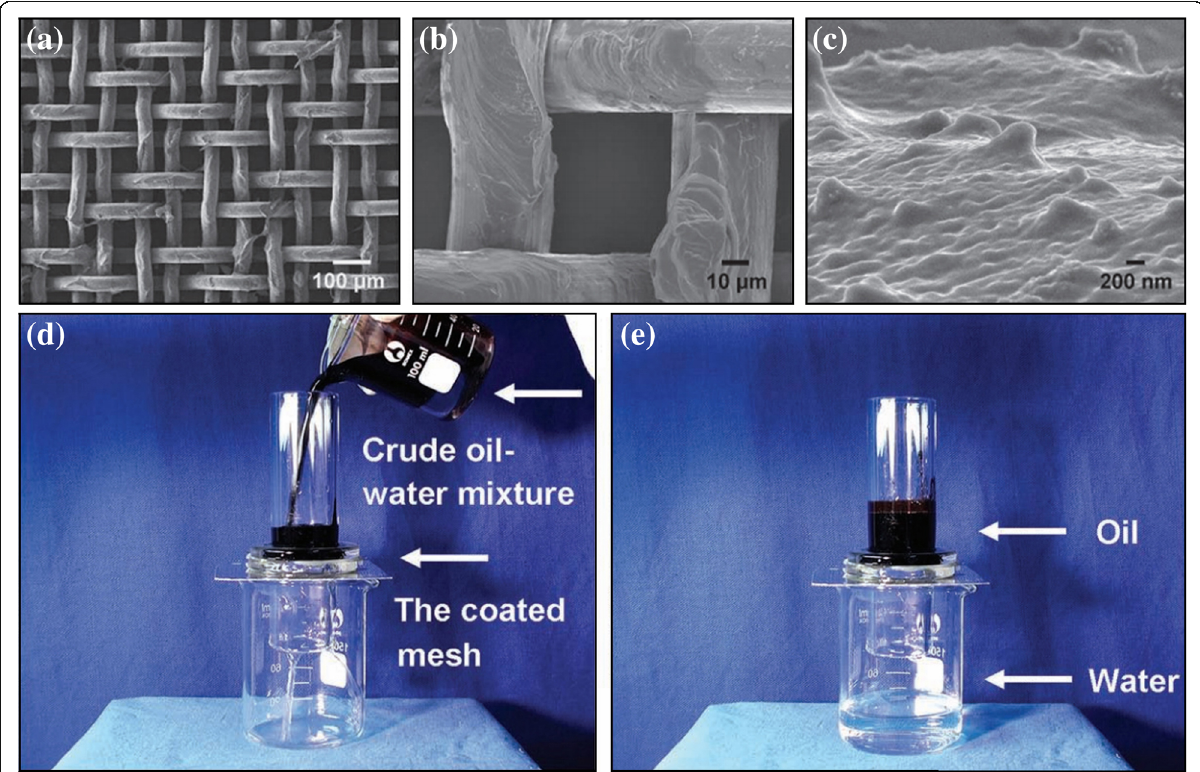
Fig. 4 a – c SEM images of the PAM hydrogel-coated mesh prepared from a stainless steel mesh with an average pore diameter of about 50 μ m [12]. d , e Oil/water separation studies of the PAM hydrogel-coated mesh. The pore size of the mesh is about 50 μ m